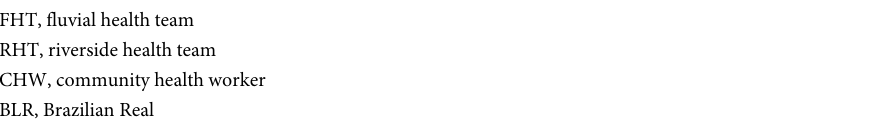
Table 3. Final hierarchical model with adjusted rate ratios for the self-reported number of missing teeth, Negro River, Manaus, Amazonas, 2019. Variable Characteristic of primary healthcare offered (ref.: locations covered by FHT and CHW, with health unit in the community) Locations covered by FHT and CHW, without health unit in the community